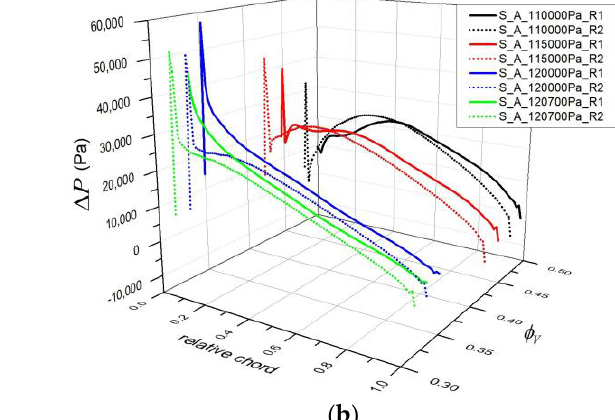
Figure 8. Load curve of blade-tip region in the S_A model. ( a ) Blade load vs. relative chord and ( b ) blade load vs. relative chord and volume flow.